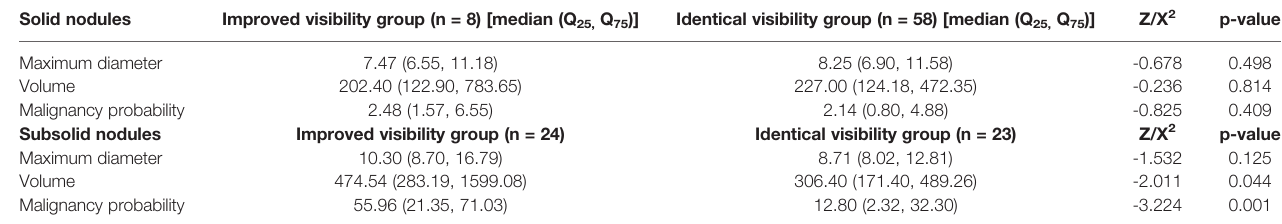
TABLE 1 | Comparisons between the improved visibility and identical visibility